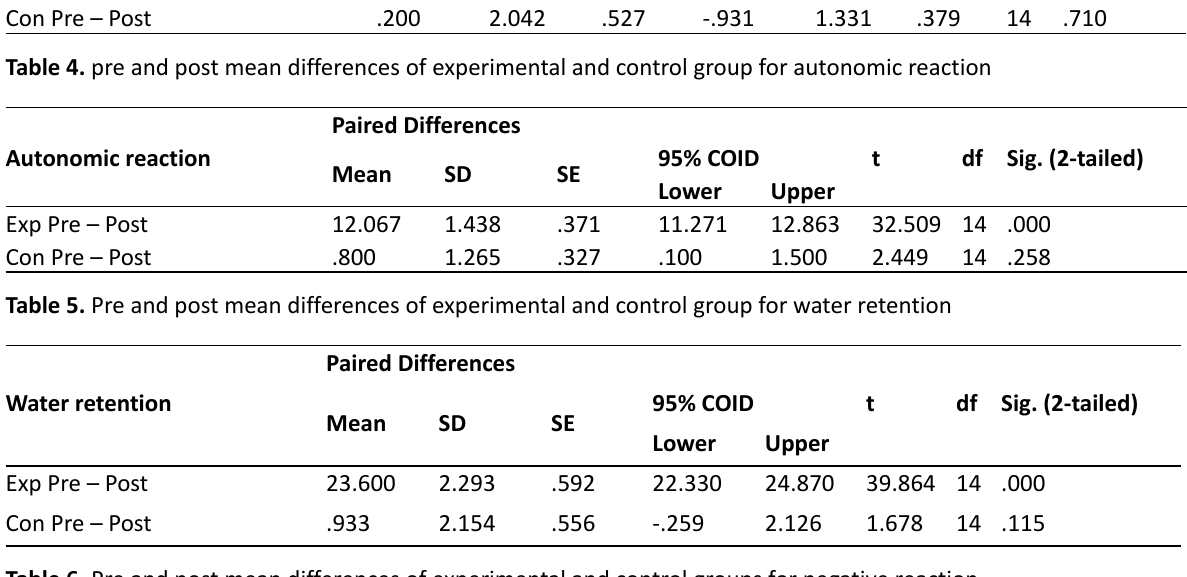
Behavioral Change